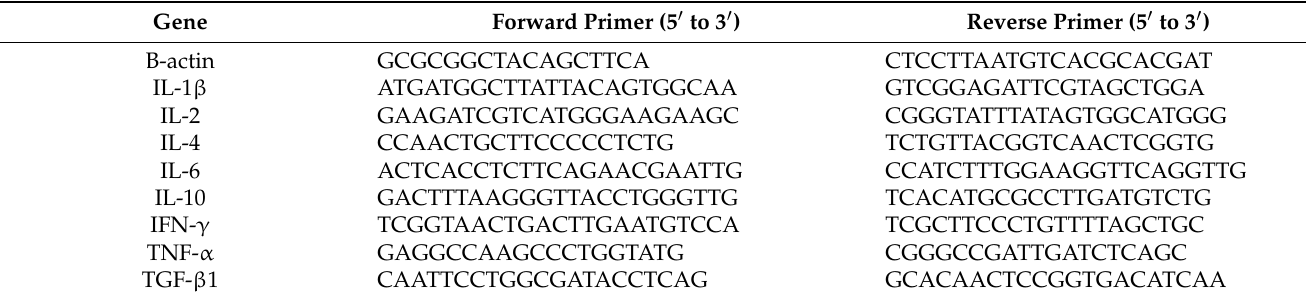
Table 1. Name of target genes and respective primer sets used to quantify mRNA levels in qPCR.